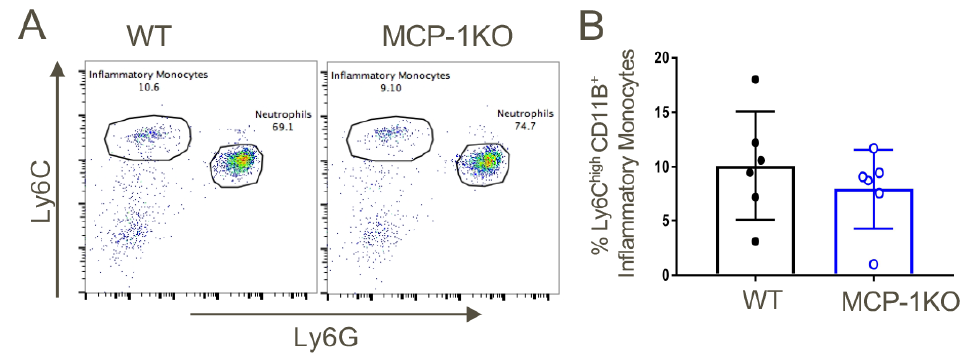
Figure 5. Analysis of baseline CD11b+Ly6C high inflammatory monocytes in MCP ‐ 1KO mice. ( A ) Similar proportions of CD11b+Ly6C high inflammatory monocytes at baseline within the peripheral blood of MCP-1KO vs. WT mice ( n = 6 / group). ( B ) Quantitative analysis (mean ± SD). Data are representative of three independent